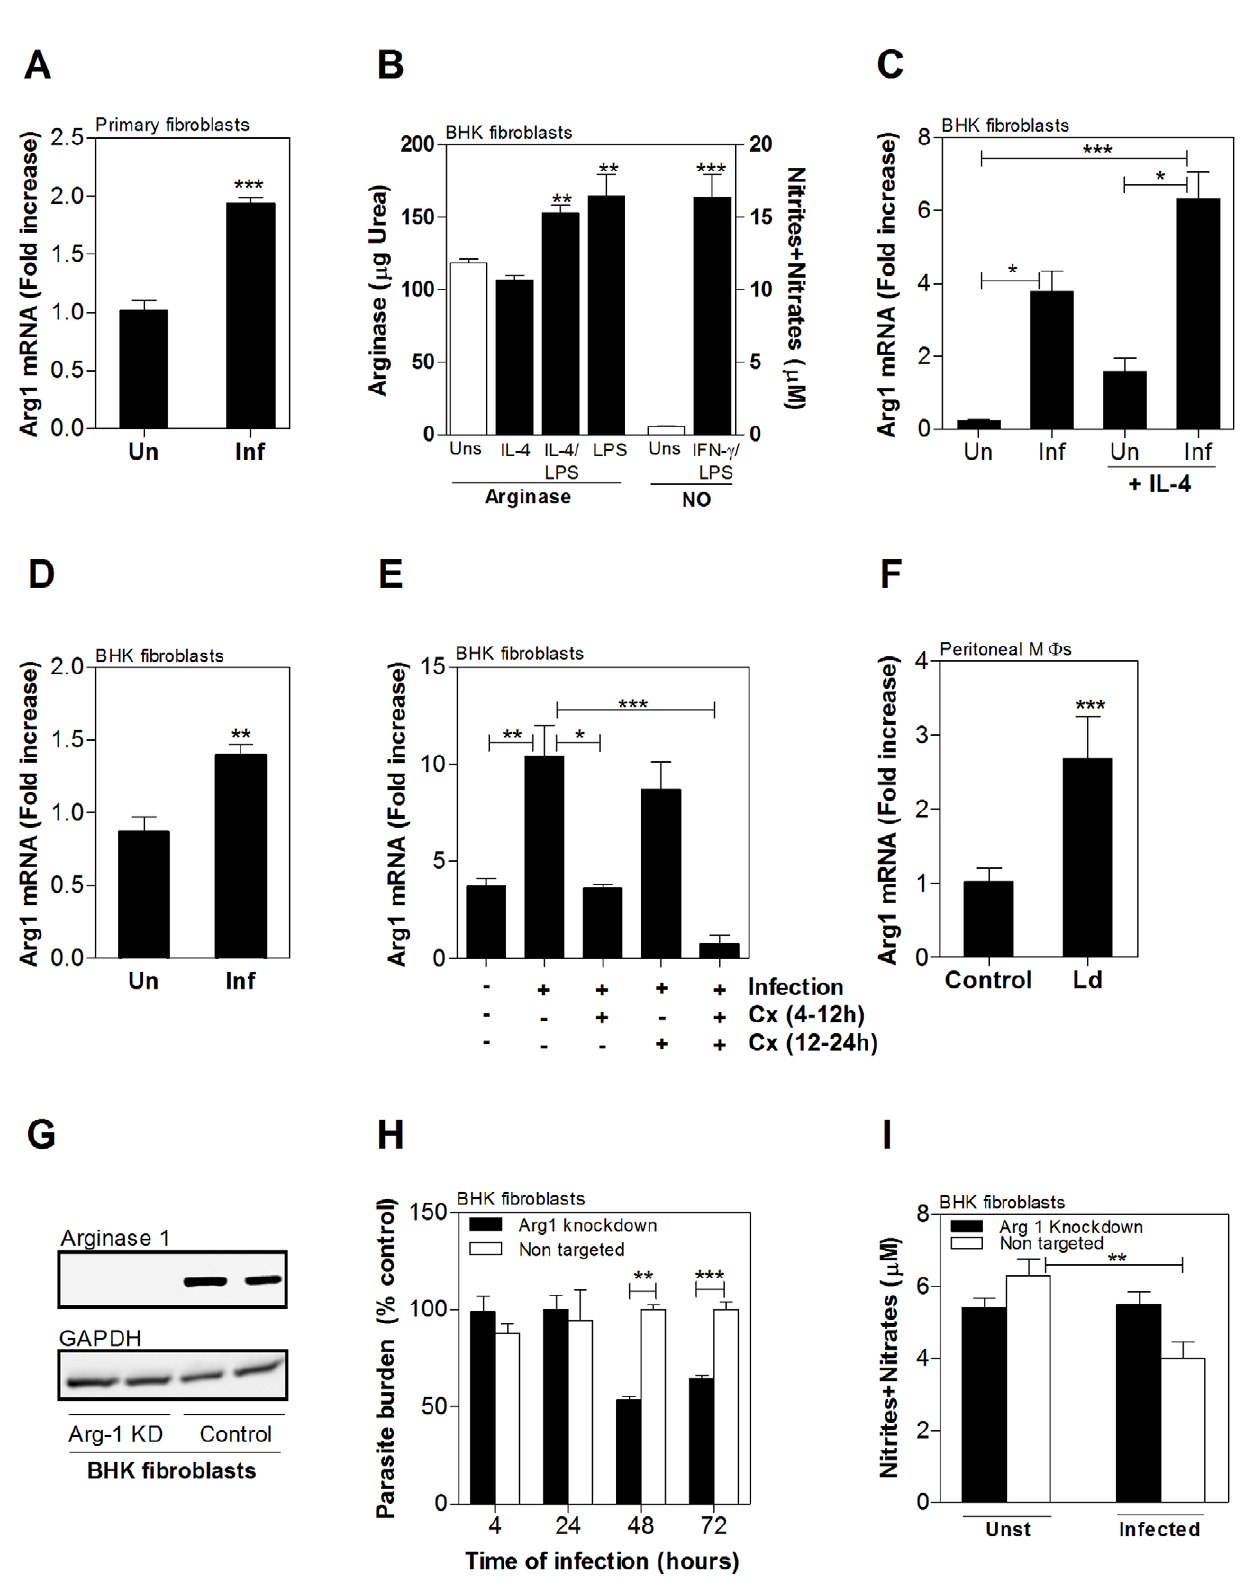
Figure 6. Parasite-induced host arg1 expression impairs macrophage anti-leishmanial activity. A ) Expression of hamster arginase mRNA in primary hamster splenic fibroblasts that were uninfected (Un) or infected in vitro with L. donovani stationary-phase promastigotes for 24 hrs (Inf). The mean and standard deviation (error bars) of the fold-increase of arg1 mRNA relative to normal BHK cells, determined by real time RT-PCR in groups of 6 animals, is shown from data pooled from 3 independent experiments. B ) Arginase activity and NO production in BHK fibroblasts. Arginase activity was determined stimulated with IL-4 or IFN- c respectively. Arginase activity was determined in BHK cells that were unstimulated (Uns) or